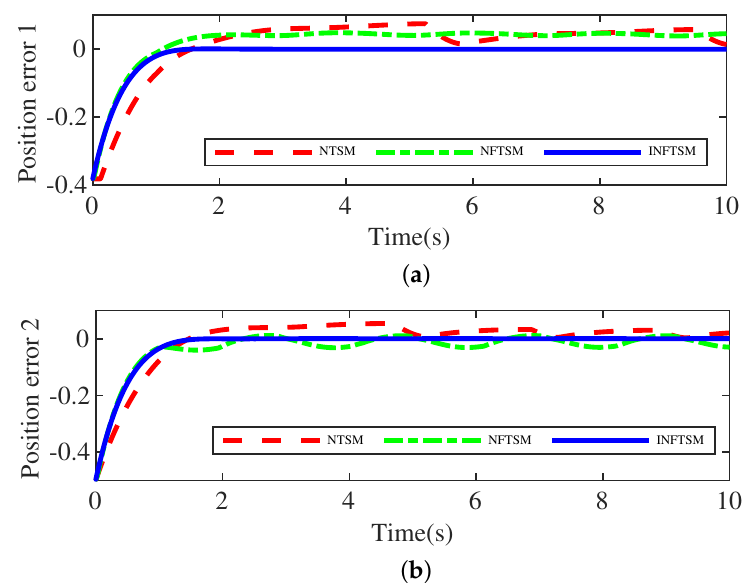
Figure 5. Comparison of position error when the system is in fault situation: ( a ) at joint 1 and ( b ) at joint 2.